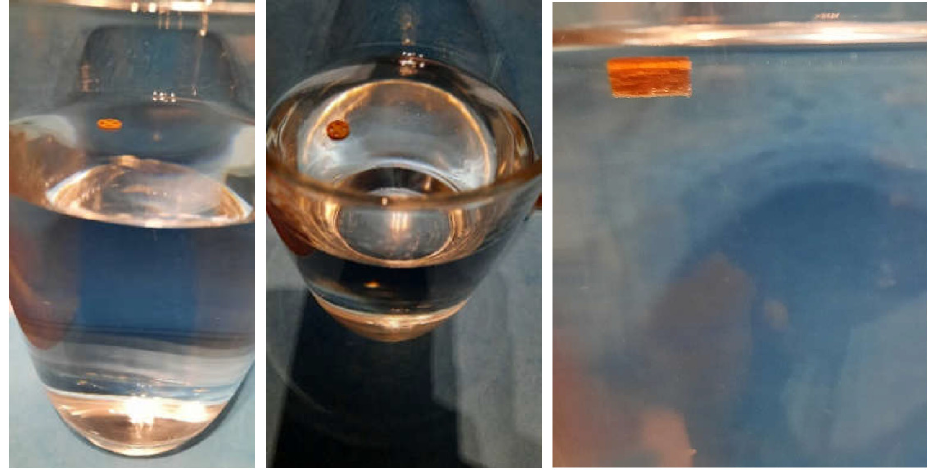
Figure 13. Floating properties of MiniHCwC in 300 mL 0.1 N HCl, 37 ± 0.5 °C.